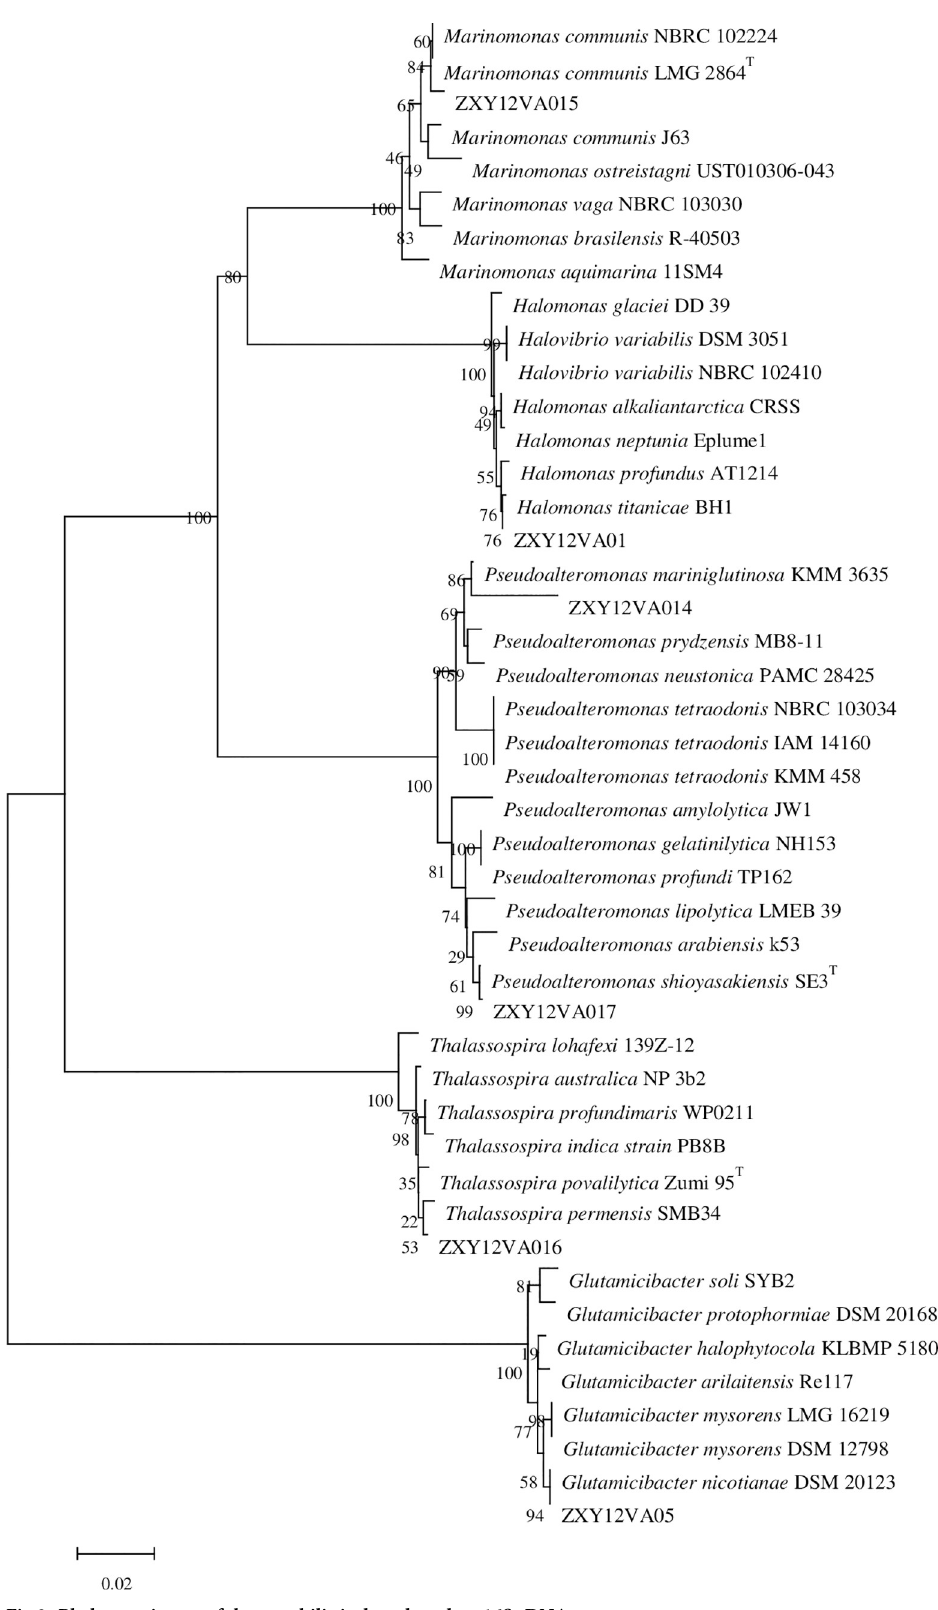
PLOS ONE | https://doi.org/10.1371/journal.pone.0240187 October 7,